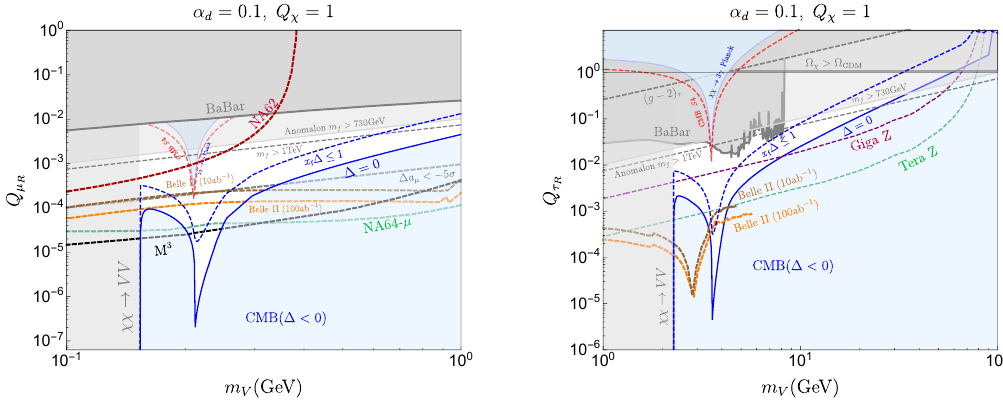
Figure 5 . Theoretical and experimental constraints on Forbidden DM annihilations through a vector mediator coupled to right-handed muon number (left) and right handed tau number (right). We show constraints from measurements of the muon anomalous magnetic moment [39–41], the tau anomalous magnetic moment [82], BaBar searches for the vector mediator [84], and Planck constraints on DM annihilations [56]. We include projections from NA64- µ [75–77], Belle II [109], and future Z factories [87]. In the white region ∆ is chosen at each point to match the observed relic density. We shade in gray the region where ordinary annihilations to a pair of mediators set the relic